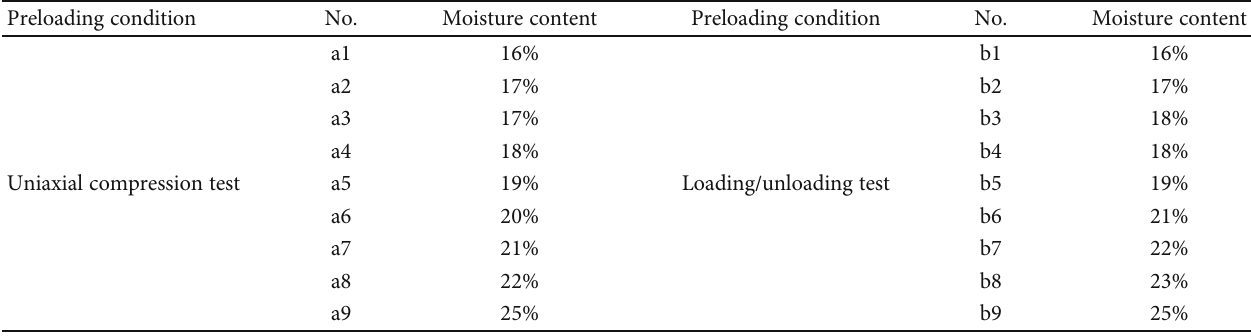
Table 1: Mechanical parameters of some coal samples.